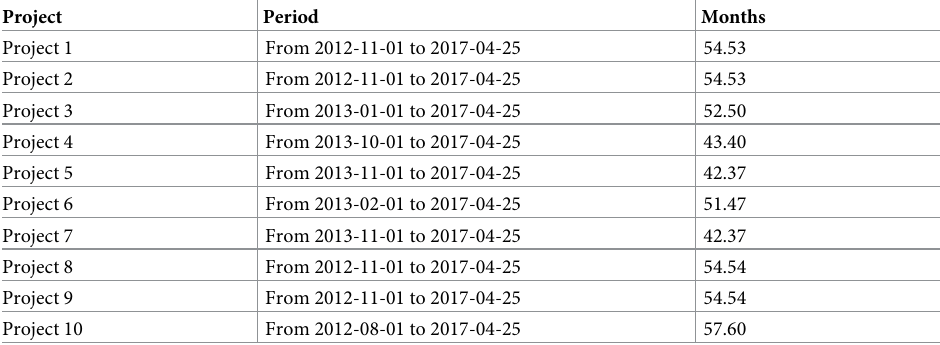
Table 2. Timeframe for the extraction of Twitter and Facebook data.